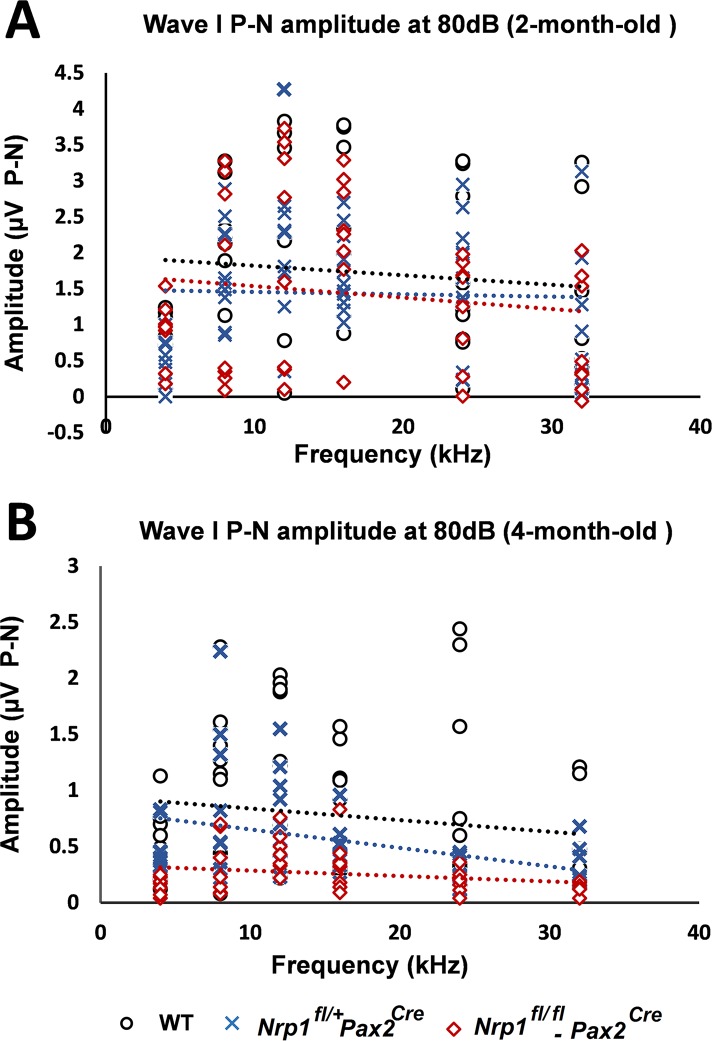
Wave I P-N amplitude for WT, Nrp1fl/+;Pax2Cre, and Nrp1fl/fl;Pax2Cre mice at 2 and 4 months of age.Analysis of the wave I P-N amplitudes at 80dB suprathreshold did not show significant difference between Nrp1fl/+Pax2Cre mice and WT controls at 2-month-old (A); however, statistically significant higher amplitudes at 8kHz, 12kHz, and 24kHz were shown in 4-month-old Nrp1fl/fl;Pax2Cre mutants compared to controls (B). *p<0.05.